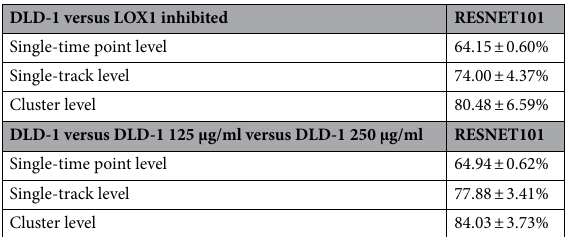
Table 7. Accuracy values of the SVM classification model at single-time point level obtained using RESNET101 transfer learning descriptors and compared with those achieved by the proposed cooperative strategies (i.e., single-track and cluster